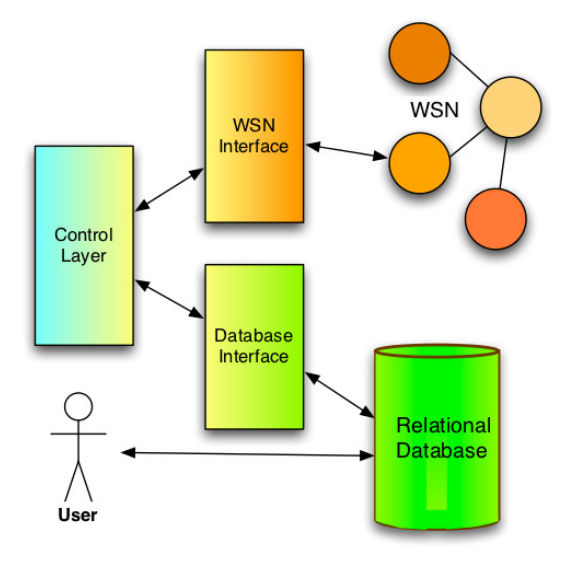
Figure 4. The WaspNet Middleware